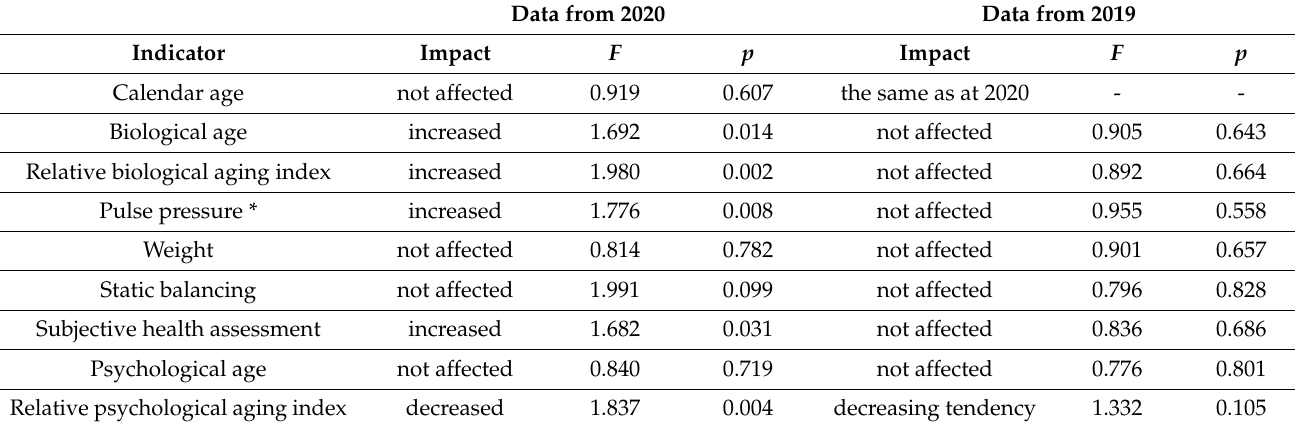
Table 3. Influence of biopsychological age indicators on the occurrence of COVID-19 in women in the working